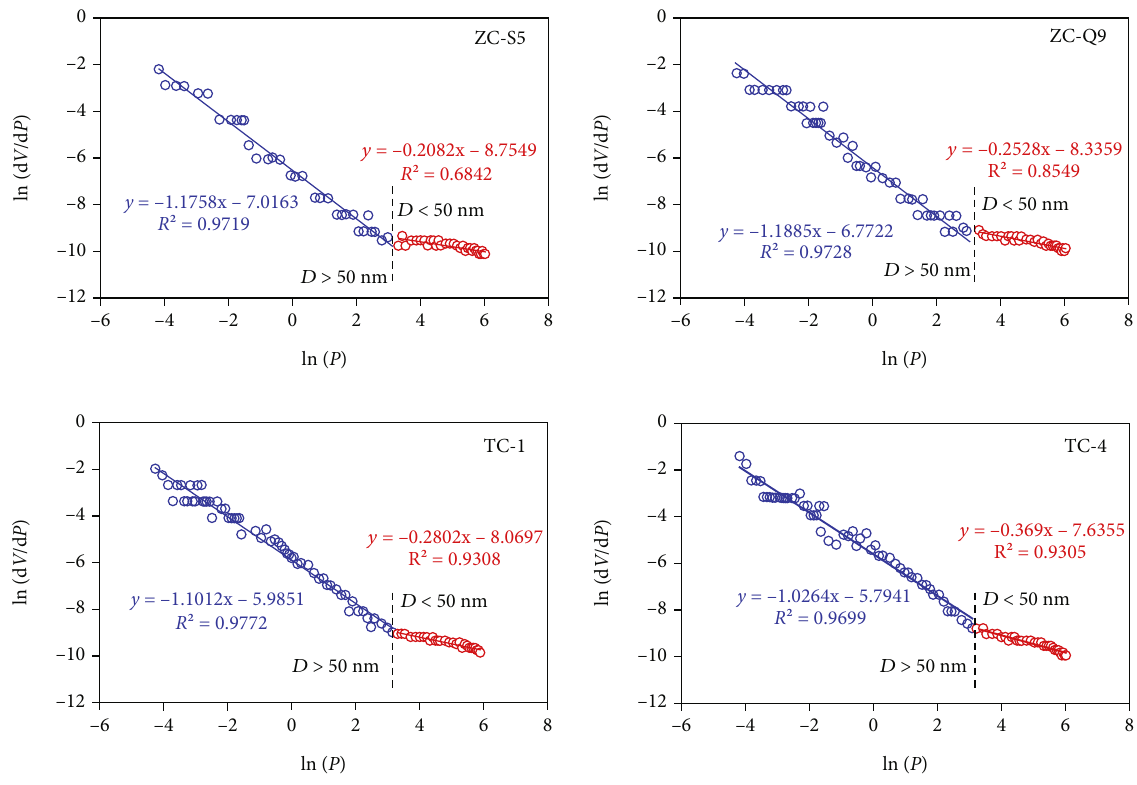
Figure 6: Plots of ln ð d V /d P Þ and ln ð P Þ of the representative coal samples based on the HP-MIP